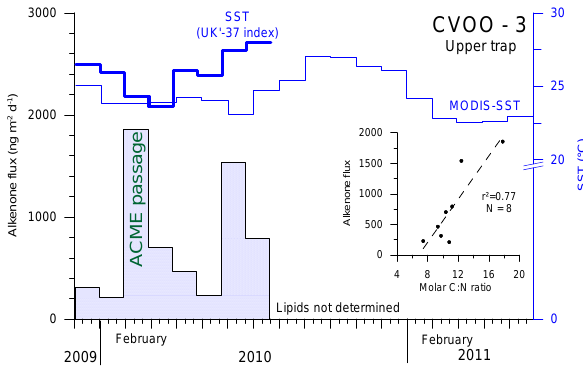
(cid:48) -derived and satel- 37